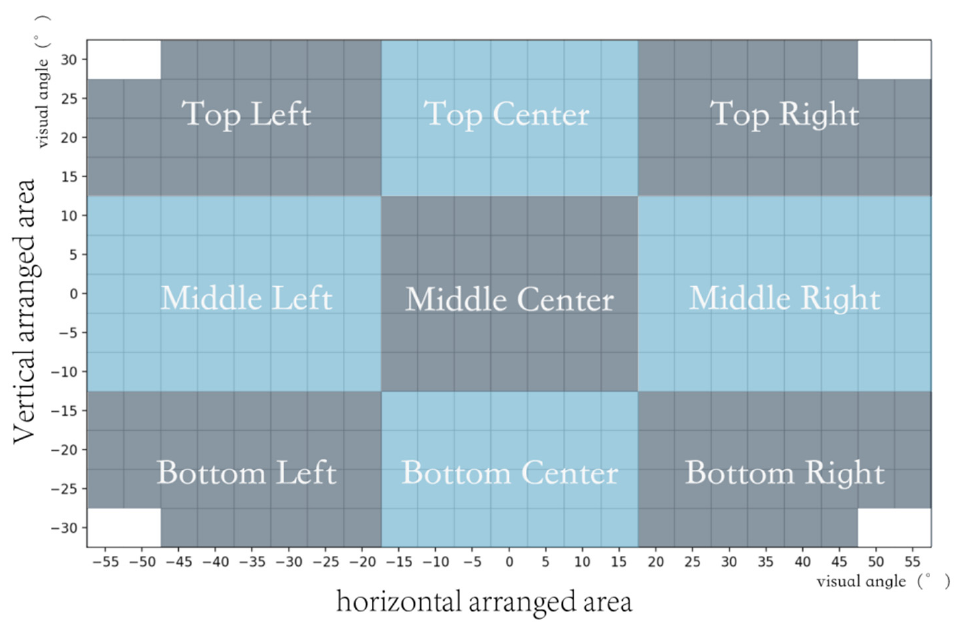
Figure 2. Schematic diagram of regional divisions. The range of the target appearance was divided into 9 parts. The position of the targets were distributed into 13 vertical arranged areas and 23 horizontal arranged areas.